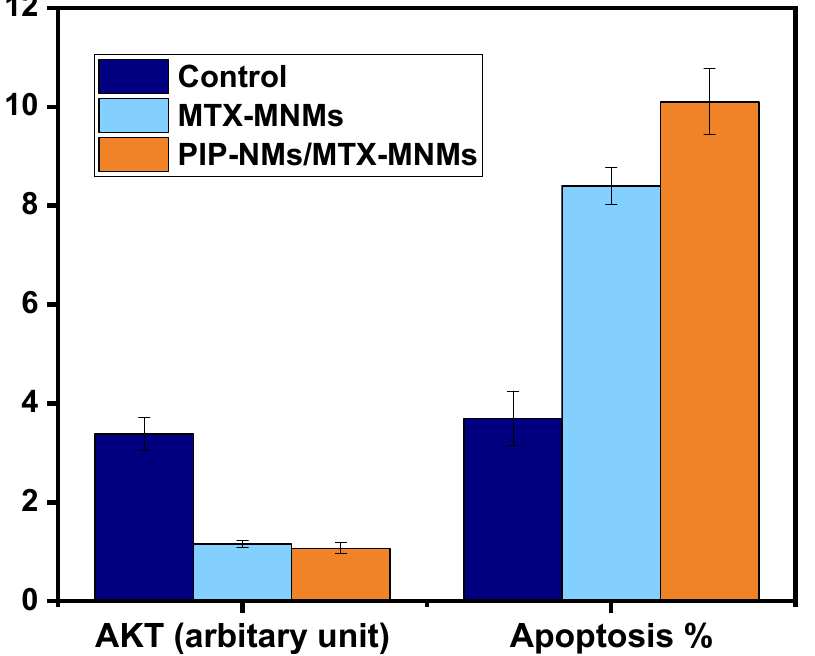
Figure 10. AKT (arbitrary unit) and apoptosis (%) determined in the MTX-MNMs and PIP-NMs/MTX-MNMs-treated groups relative to the control group. Data represented as mean ± SD ( n = 7).